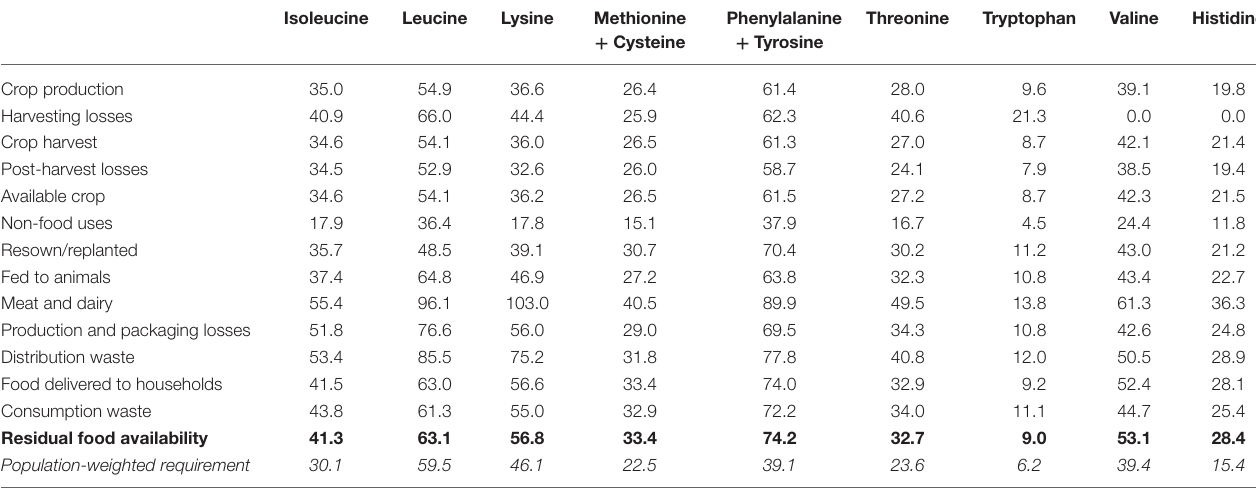
TABLE 1 | Aggregate amino acid profiles by stage in food supply chain.